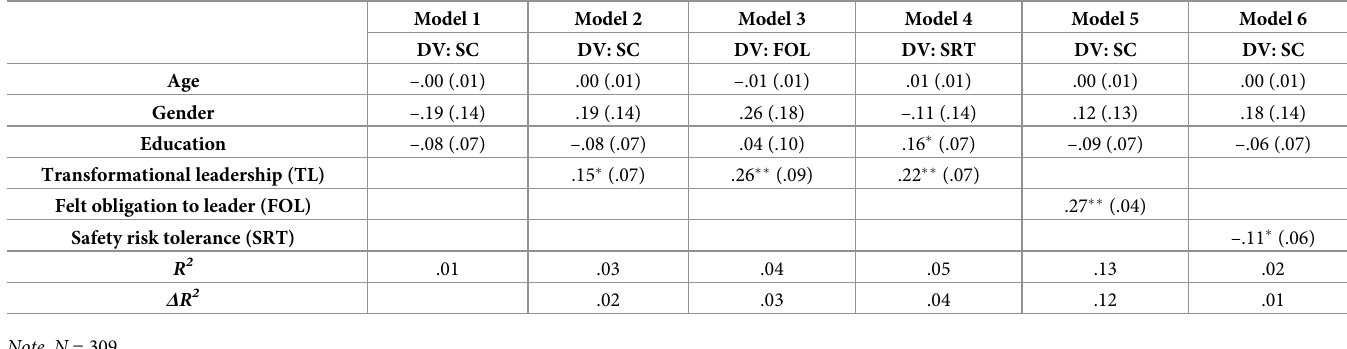
Table 4. Results of hierarchical regression analyses.